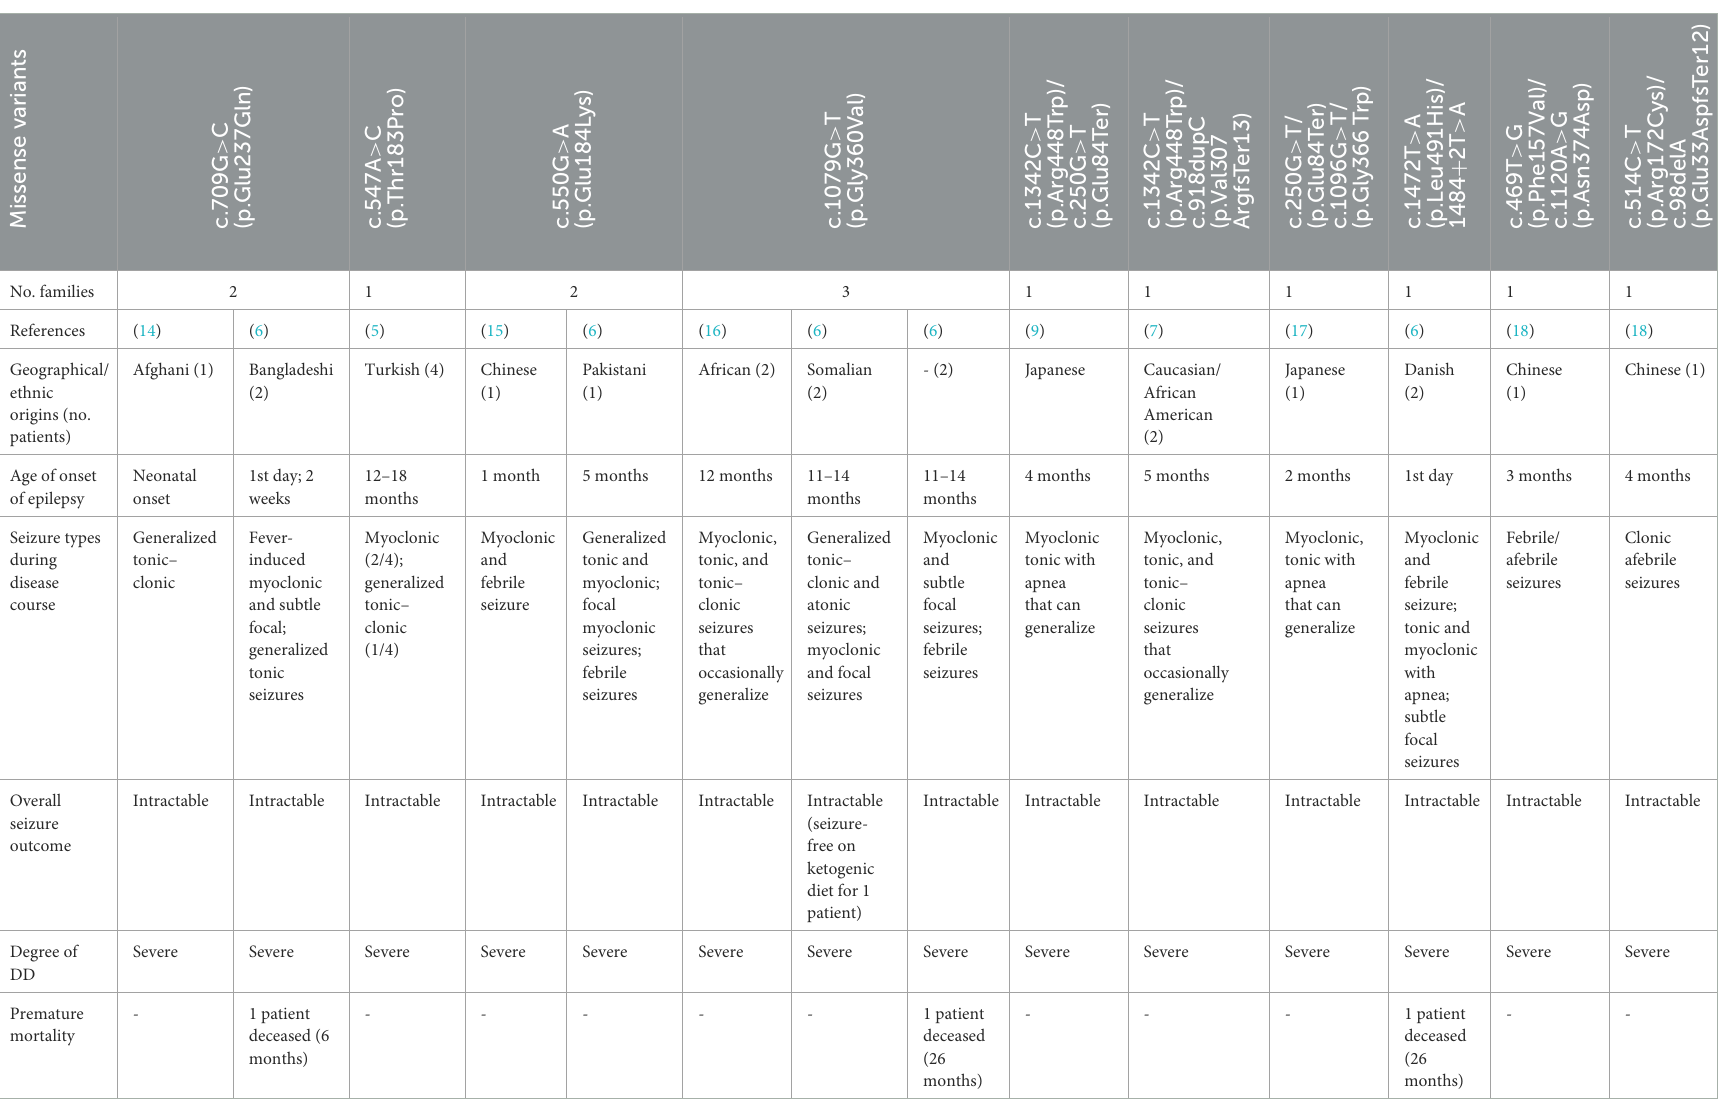
TABLE 2 Published clinical findings in individuals harboring a severe phenotype of PIGT deficiency associated with missense